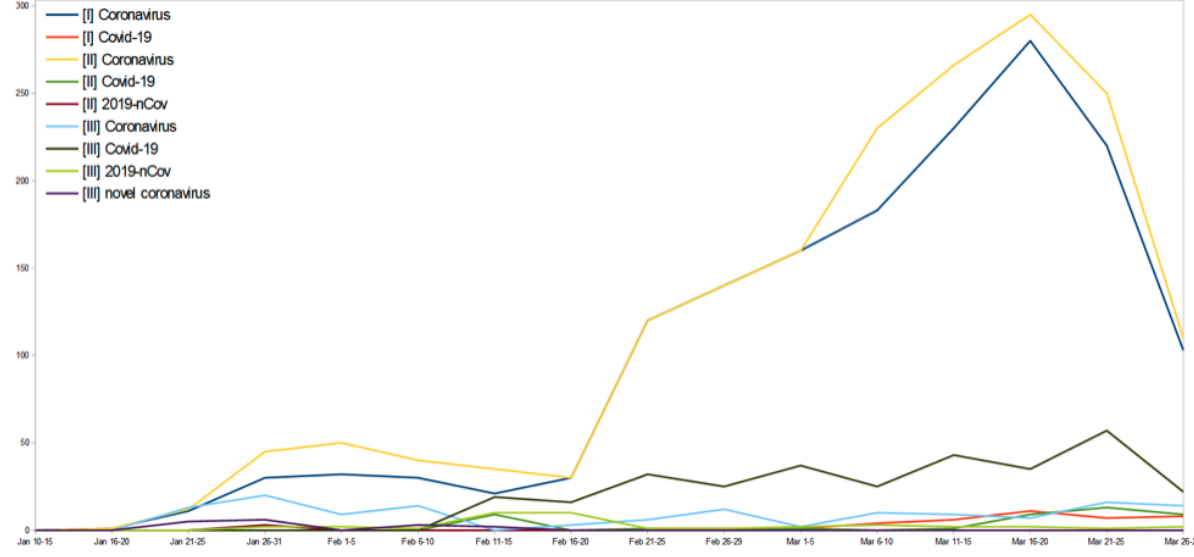
Figure 3. Keywords used to identify information related to coronavirus disease (COVID-19): Il Sole 24 Ore (I) and La Repubblica (II) newspapers, and government bulletins (III).